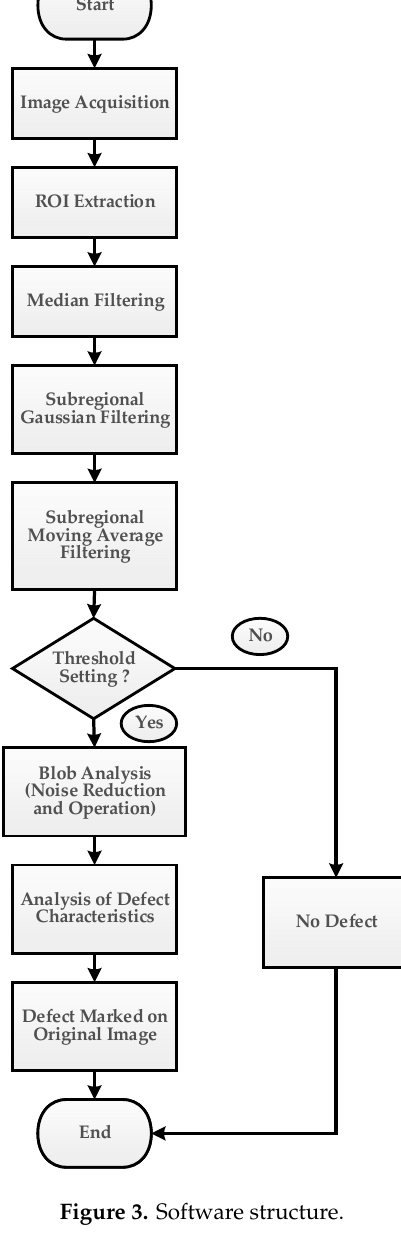
Figure 3. Software structure.